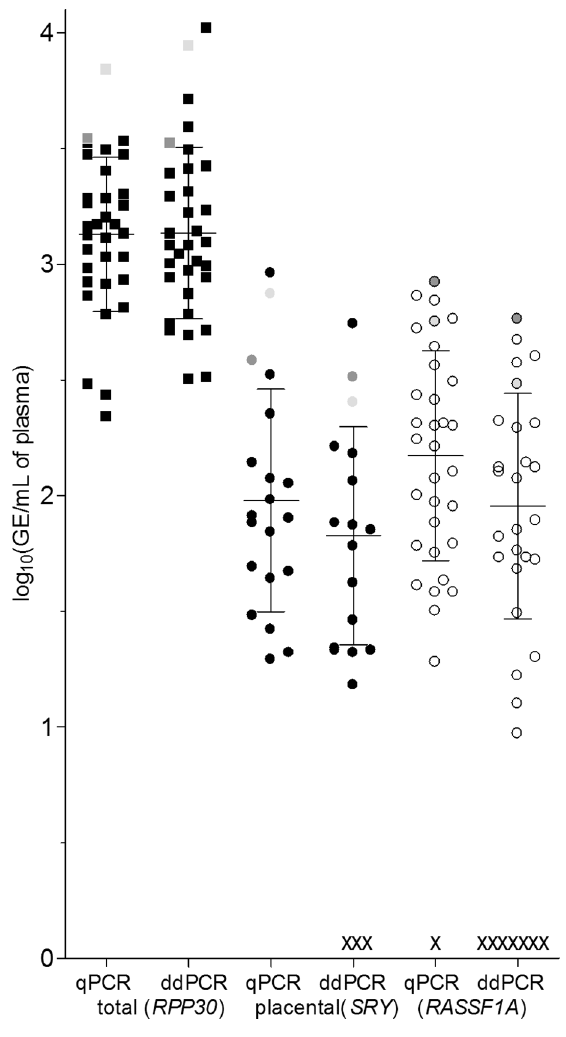
Figure 1. Quantification of total and fetal cfDNA with RPP30/ SRY and RASSF1A/ b _Actin -specific assays using qPCR and ddPCR. All values are presented in logged (GE/mL) and bars represent mean and standard deviation. Specific values: Light grey - Preeclampsia with HELLP syndrome at 29th week of gestation, dark grey - IUGR in twins. Each ‘‘x’’ represents a data point that has not been detected with the given approach. non-template controls (restricted whole blood for RASSF1A / b - Actin , plasma DNA from female-bearing pregnancy for RPP30/